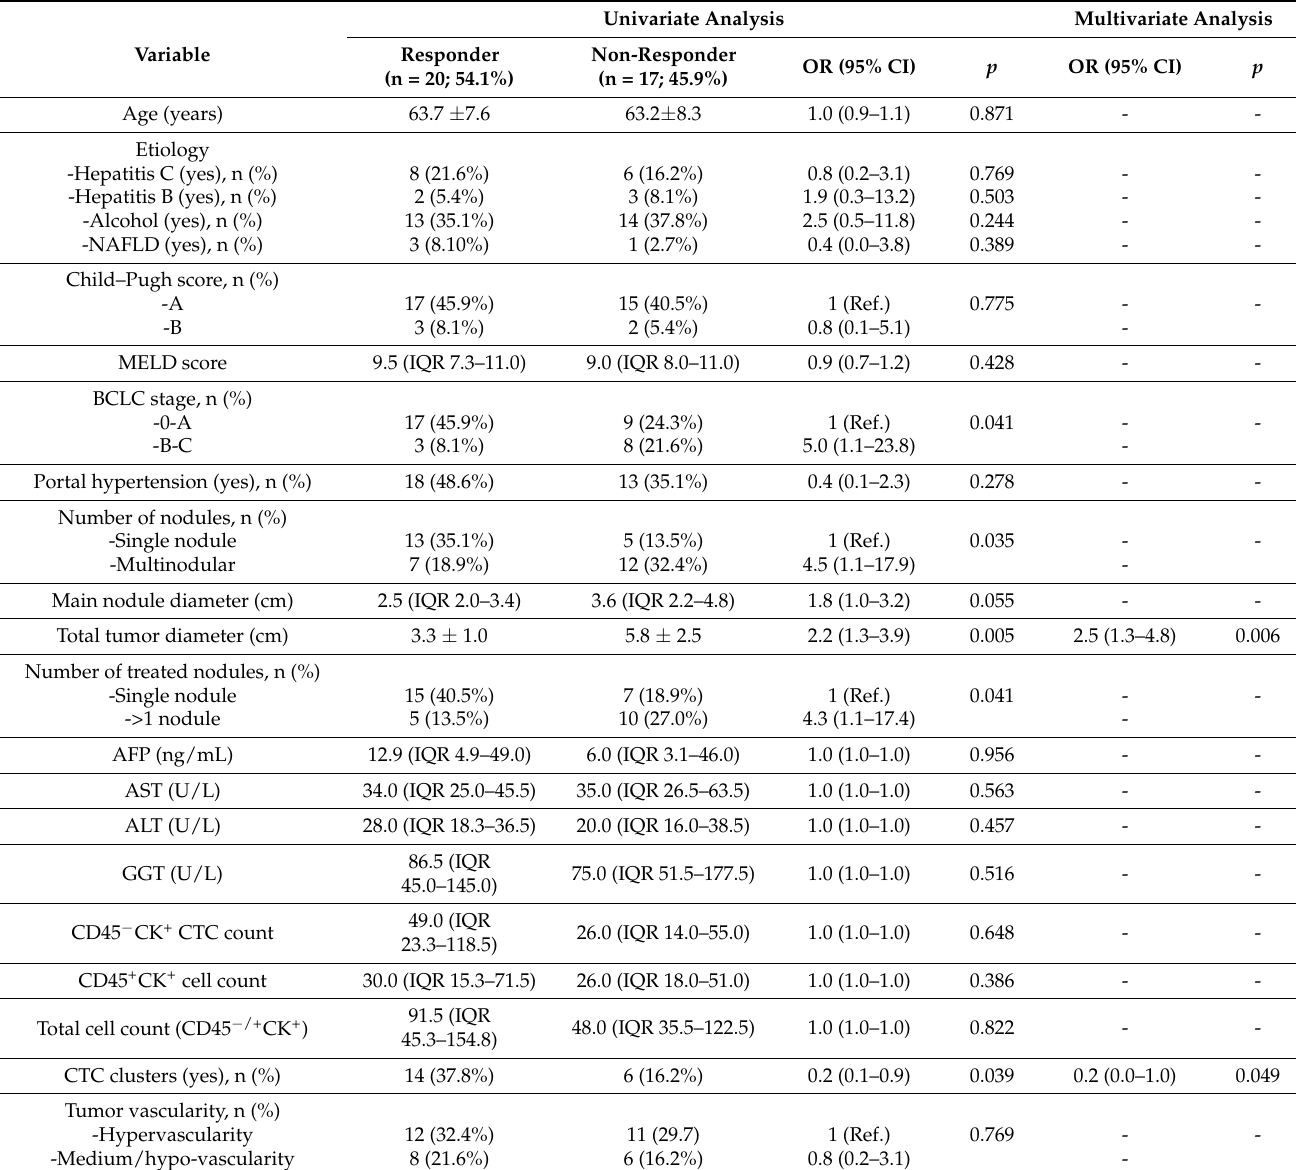
Table 3. Univariate and multivariate logistic regression comparing patients with and without ra- diological response to TACE. Radiological response was evaluated one month after the procedure by dynamic imaging techniques following the mRECIST criteria, on the group of responders who attained a complete radiological